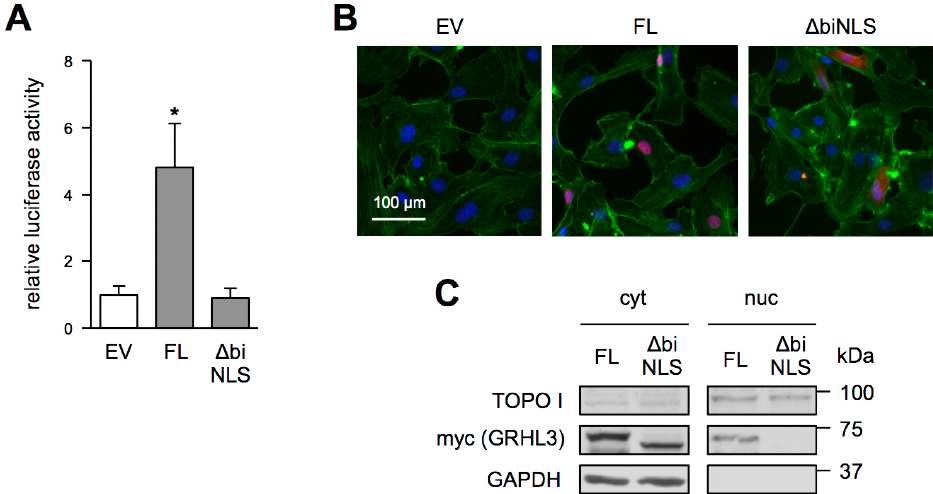
Figure 3. Transcriptional activity and intracellular localization of GRHL3 FL and GRHL3 ∆ biNLS in EC. ( A , B ) EC were transfected with an empty vector (EV), GRHL3 FL (FL) or GRHL3 ∆ biNLS ( ∆ biNLS) plasmids. ( A ) Relative luciferase activity was measured in lysates of cells co-transfected with the GRHL3-specific luciferase reporter plasmid (data are mean ± SEM, n = 5, * p < 0.05 vs. EV). ( B ) Representative immunostainings. Nuclei were stained with DAPI (blue), GRHL3 FL and GRHL3 ∆ biNLS were detected with an antibody against the myc-tag (red), the actin cytoskeleton was stained with Phalloidin (green). The merge of all channels is shown. ( C ) EC were transfected with GRHL3 FL (FL) or GRHL3 ∆ biNLS ( ∆ biNLS) plasmids. Representative immunoblots. Biochemical fractionation in cytosolic (cyt) and nuclear (nuc) fractions. Topoisomerase I (TOPO I, upper panels) and GAPDH (lower panels) served as purity controls of nuclear and cytosolic fractions, respectively. Myc represents the detection of the C-terminal myc-tag of GRHL3 FL and GRHL3 ∆ biNLS (middle panels).